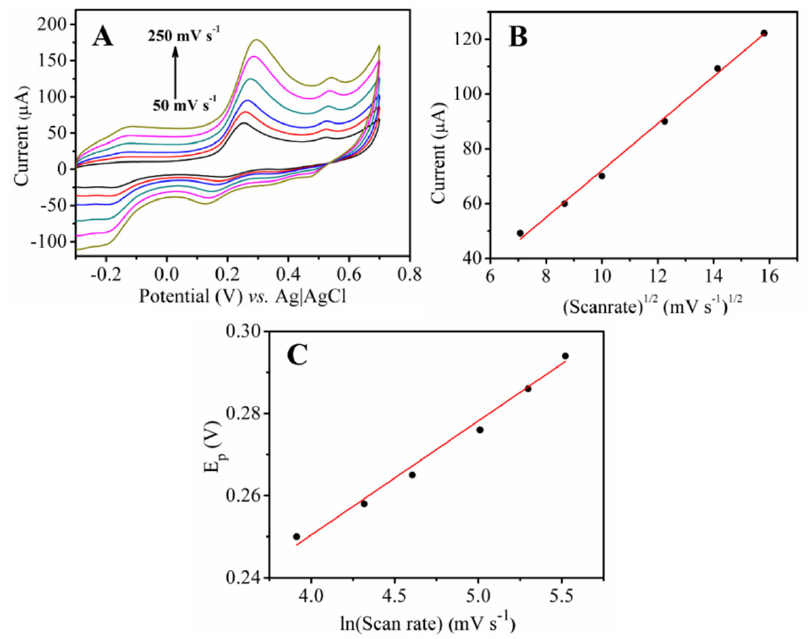
Figure 5. ( A ) Cyclic voltammogram of 0.5 mM 5-HT in 0.1 M PBS (pH 7.4) at the NH-HNP-Chit/SPCE with different scan rates (25 to 250 mV/s). ( B ) Plot of peak current vs. the square root of the scan rate. ( C ) Plot of peak potential vs. ln(scan